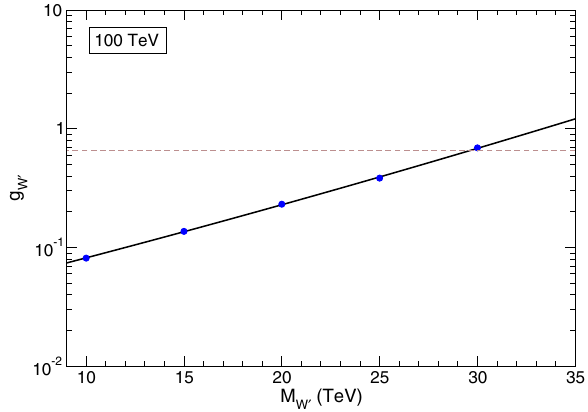
Fig. 12 Signal and background cross sections as a function of the invariant mass m Jj ν for the W (cid:2) signals and the SM background, for the high-mass W (cid:2) search. In the W (cid:2) signals we set g W (cid:2) = 0 . 1